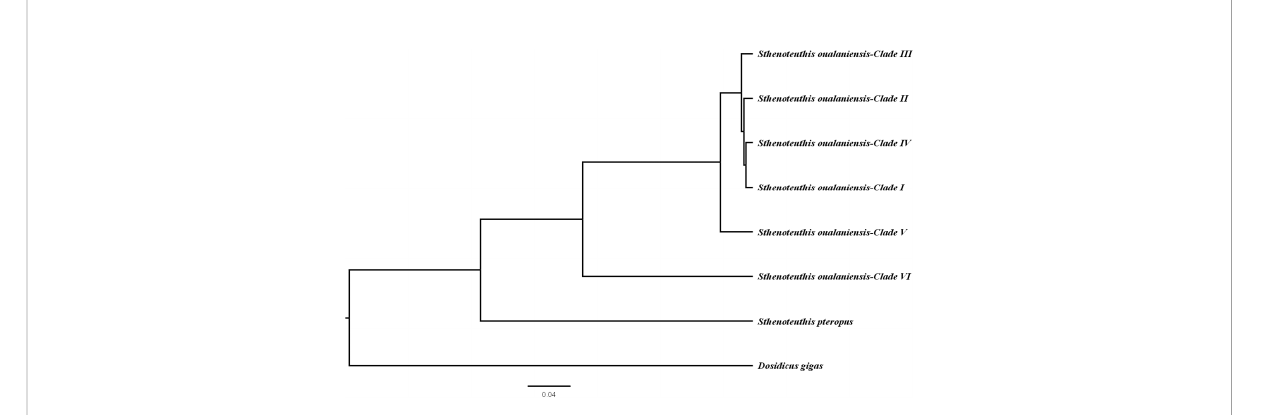
FIGURE 3 Species tree of the genus Sthenoteuthis showing the phylogenetic relationship of the